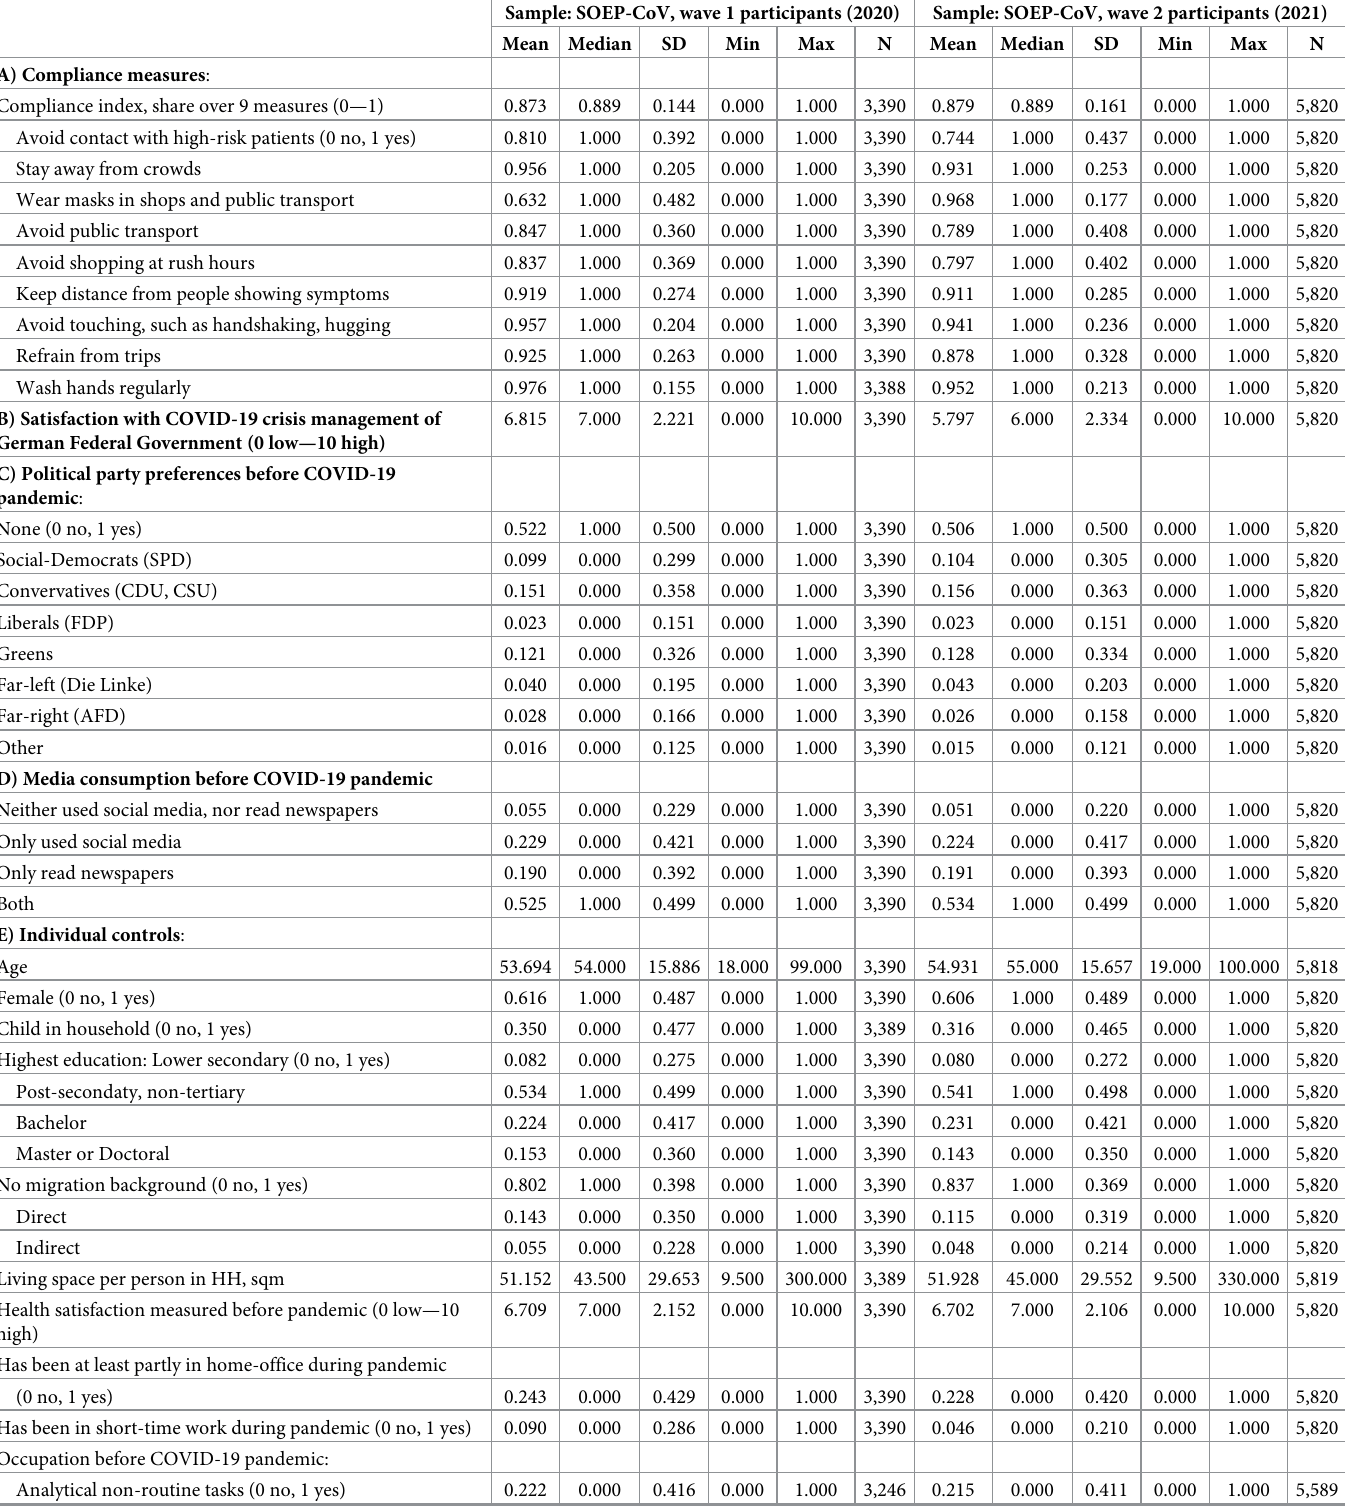
Table 2. Descriptive statistics of all